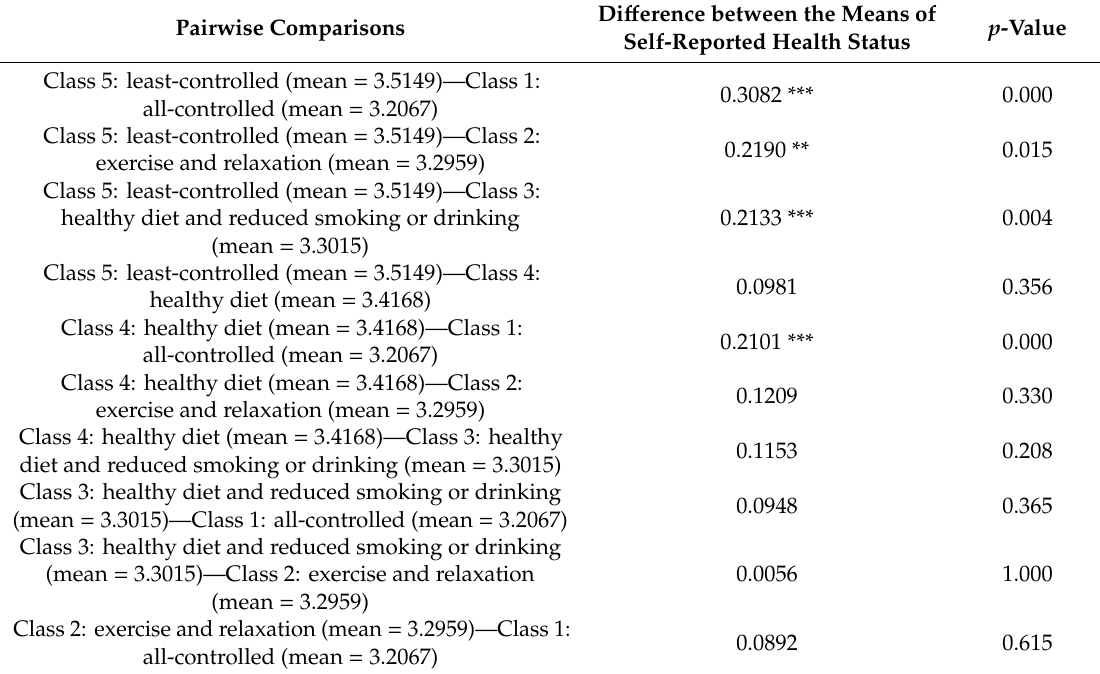
Table 5. Pairwise comparisons for each latent